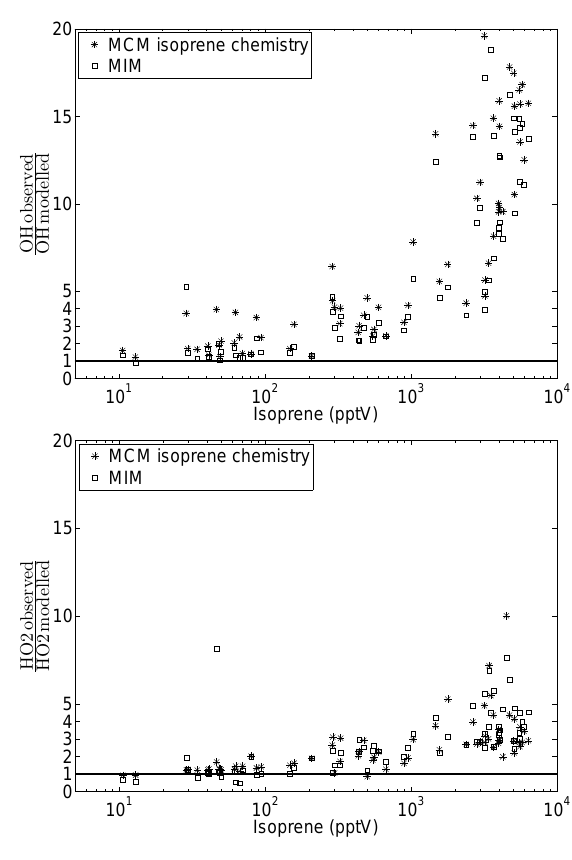
Fig. 12. Deviations between observations and model results as a function of isoprene mixing ratios.